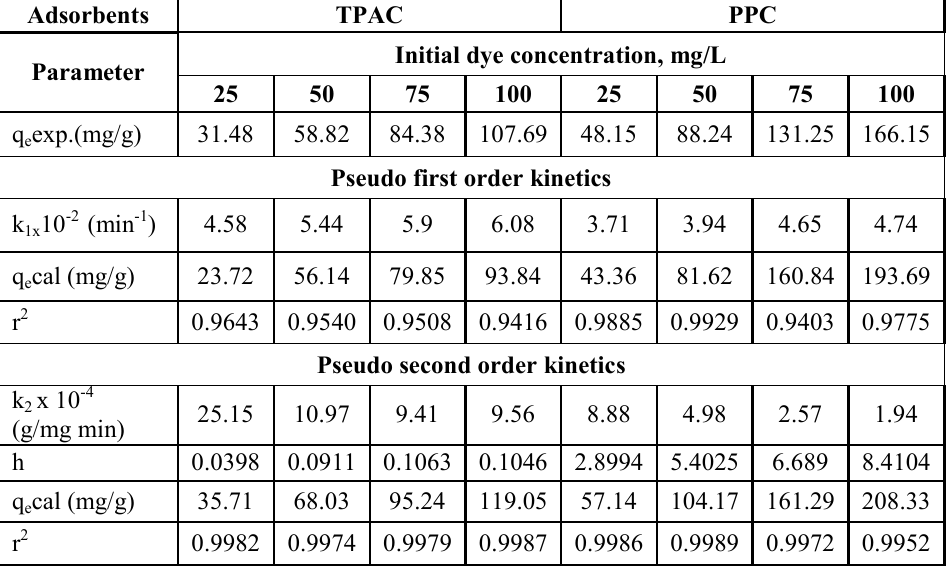
Table 2(a). Kinetic parameters for the adsorption of direct dye DB 71 onto TPAC and PPC with different initial dye concentration at temperature 30°C.